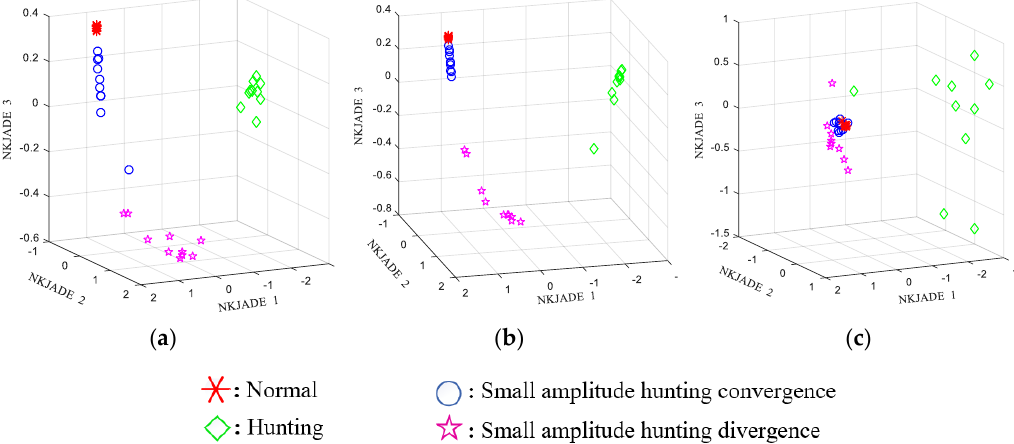
Figure 8. Scatter plot of feature extraction from single sensor using Non-stationary Kernel JADE (NKJADE). ( a ) S1 (bogie frame); ( b ) S2 (bogie frame); ( c ) S3 (axle box). Table 4. Separability J running time and accuracy of NKJADE method.